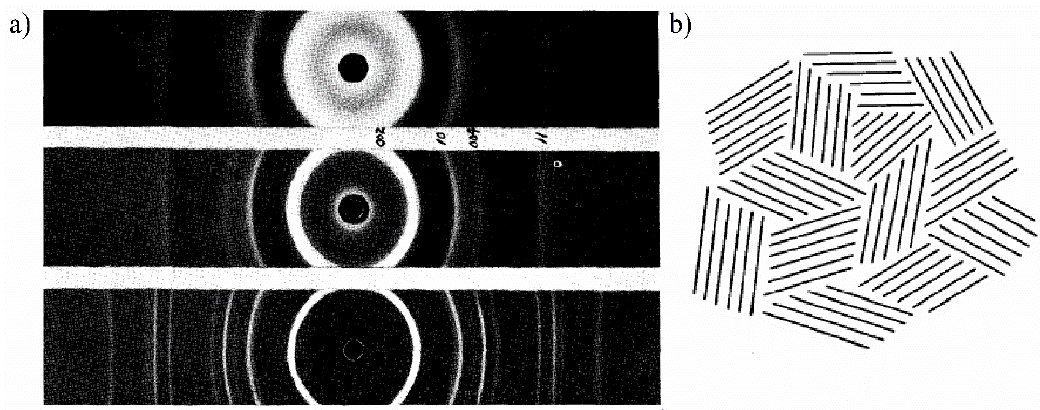
Figure 1. ( a ) X-ray diffraction (XRD) patterns of unheated Spheron Grade 6 carbon black (top), the same carbon black heated for 2 h at 2000 °C (middle), and graphite (bottom). ( b ) A first model of the carbon black structure assuming turbostratic disorder of graphite layers. Reproduced with permission from Biscoe and Warren [19]. Copyright AIP Publishing, 1942.